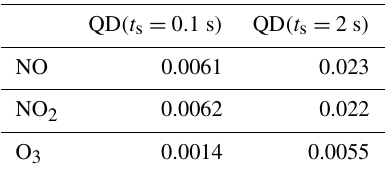
Table 4. Quadratic relative differences of concentration different time step